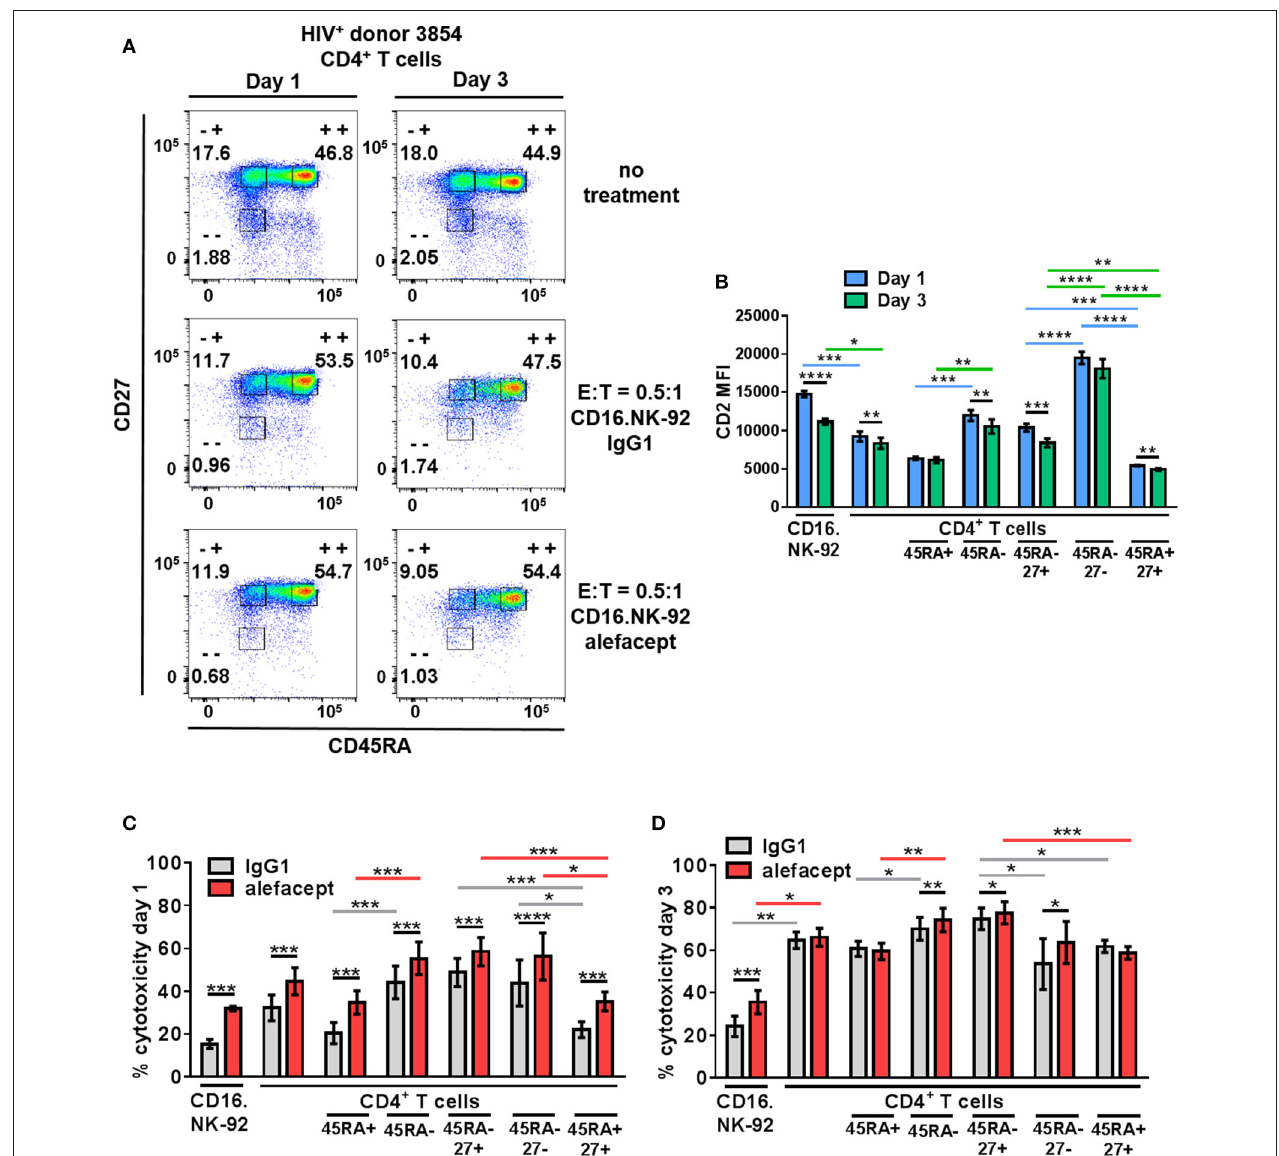
FIGURE 5 | CD16.NK-92 and alefacept also target CD45RA– CD27 + T( CM / TM ) CD4 + T cell subset in HIV + donors. (A) Representative flow cytometry plots of HIV + CD4 + T cell donor with memory subsetting at 19h (1 day) and 3 days with no treatment, with CD16.NK-92 and 10 µ g/mL alefacept or IgG1 control antibody at E:T = 0.5:1. (B) CD2 MFI of all cell types and subsets in co-culture at days 1 and 3. (C) Percent cytotoxicity of CD16.NK-92, CD4 + T cells, and CD4 + T cell subsets in HIV + donors after co-culture for 19h (1 day) with 10 µ g/mL alefacept or IgG1 control antibody at E:T = 0.5:1 as measured by absolute count flow